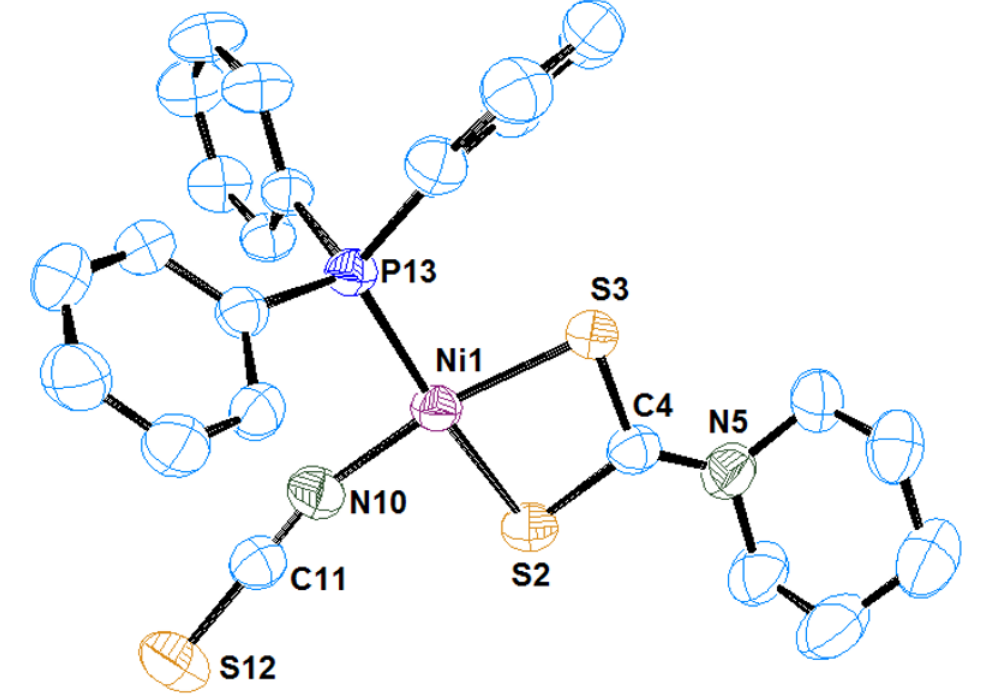
Figure 4. ORTEP of [Ni(pipdtc)(PPh